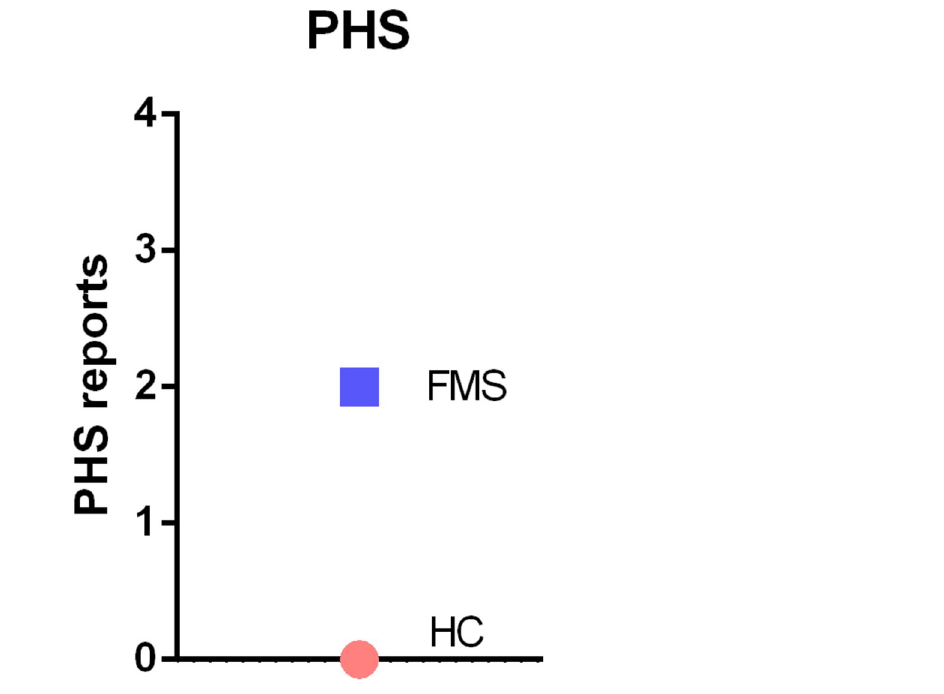
Fig 6. Z-adjusted values of paradoxical heat sensations measured in quantitative sensory testing in FMS patients relative to healthy controls. We used ANOVA for statistical testing. PHS = paradoxical heat sensations.